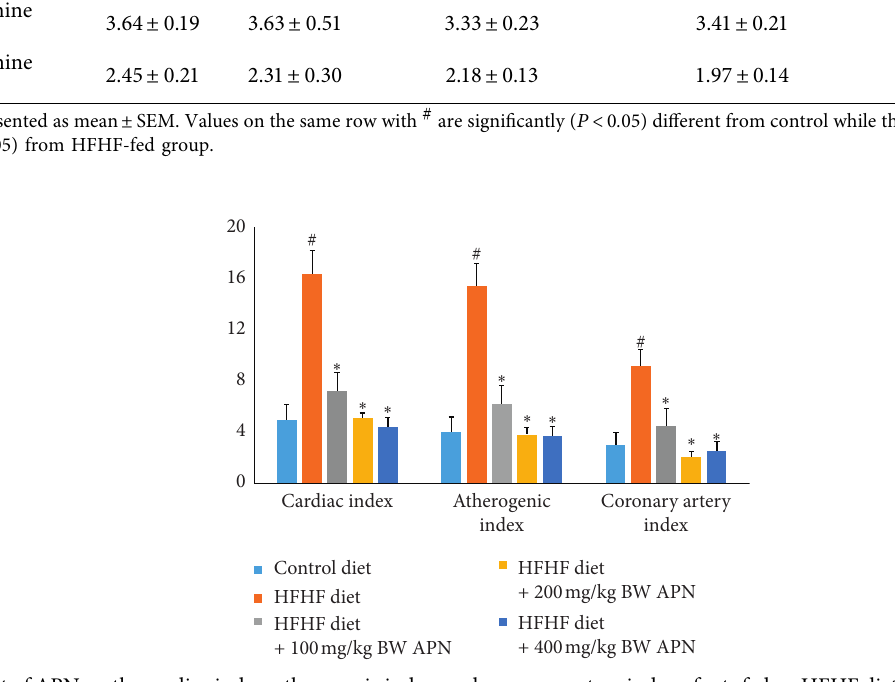
Figure 3: Effect of APN on the cardiac index, atherogenic index, and coronary artery index of rats fed an HFHF diet. Values are represented as mean ± SEM of at least five biological replicates. Bars with # are significantly ( P < 0 . 05) different from control while bars with ∗ are significantly different ( P < 0 . 05) from HFHF-fed